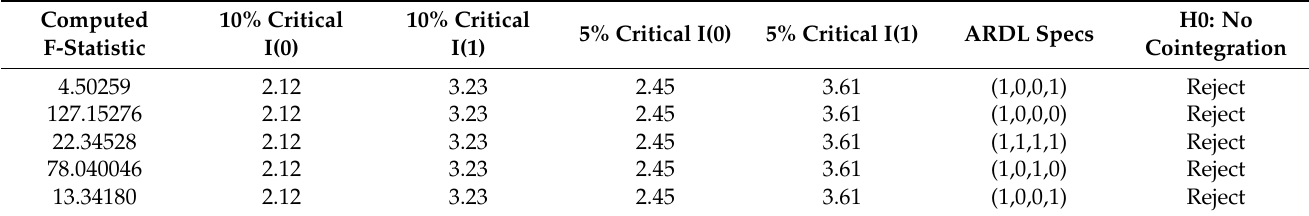
Table A1. The results of the bounds test for cointegration for SMB.